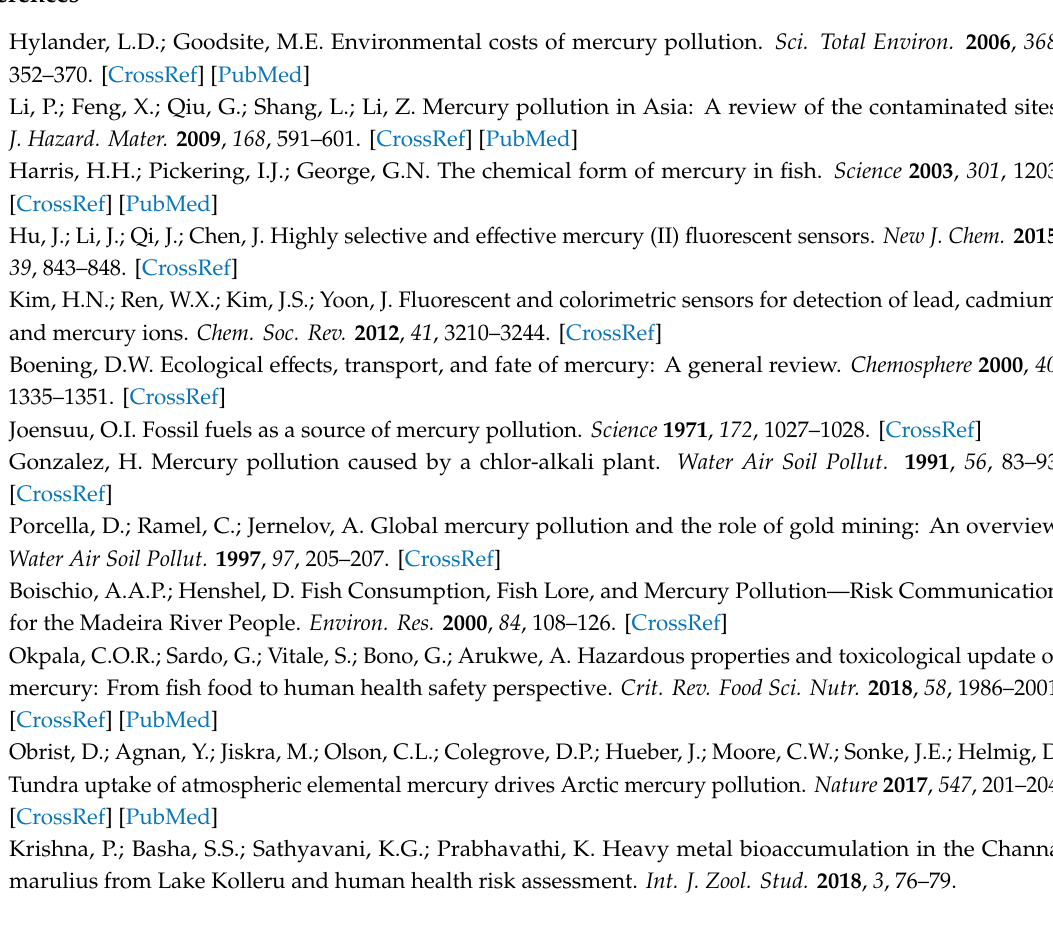
Figure S26: A correlation between the observed absorbance and absorbance value calculated using the program for a titration between 1 and ferric ions with 1:1 (H:G) binding stoichiometry, Figure S27: A correlation between the observed absorbance and absorbance value calculated using the HypSpec program for a titration between 1 and aluminum ions with 1:1 (H:G) binding stoichiometry, Figure S28: A comparison of the absorbance and fluorescence intensity for an equimolar solution of 1 and the mercuric ions, Figure S29: A partial 1 H-NMR spectra of 1 and 1 -Hg 2 + showing a comparison in the aliphatic region, Figure S30: The 1 H-NMR spectra was recorded in DMSO- d 6 on a 400 MHz instrument, Figure S31: A partial 1 H-NMR spectra of 1 and 1 -Al 3 + showing a comparison in the aromatic region. The 1 H-NMR spectra was recorded in DMSO- d 6 on a 400 MHz instrument, Figure 32: A partial 1 H-NMR spectra of 1 and 1 -Al 3 + showing a comparison in the aliphatic region. The 1 H-NMR spectra was recorded in DMSO- d 6 on a 400 MHz instrument, Figure S33: The determination of limit of detection value of 1 towards mercuric ions using fluorescence spectroscopy, Figure S34: The DFT / PBE1PBE / 6-31 + G(d) optimized geometries of the di ff erent stereoisomers of 1 , Figure S35: The DFT / PBE1PBE / 6-31 + G(d) optimized geometries of the di ff erent stereoisomers of 1 in the zwitterionic form, Figure S36: The DFT / PBE1PBE / 6-31 + G(d) optimized geometries of the di ff erent stereoisomers of 1 in the protonated form, Figure S37: The DFT / PBE1PBE / 6-31 + G(d) / LANL2DZ optimized geometries of the 1 -Hg complex; Table S1: Experimental detail. Table S2: The contribution of di ff erent intermolecular interaction to the total Hirshfeld surface; Table S3: The electronic excitation parameters for the receptors 1 and 1 -Hg 2 + complex obtained calculated using TD-DFT / B3LYP / 6-31G(d) method (Gaussian 09 A.02) in the gas